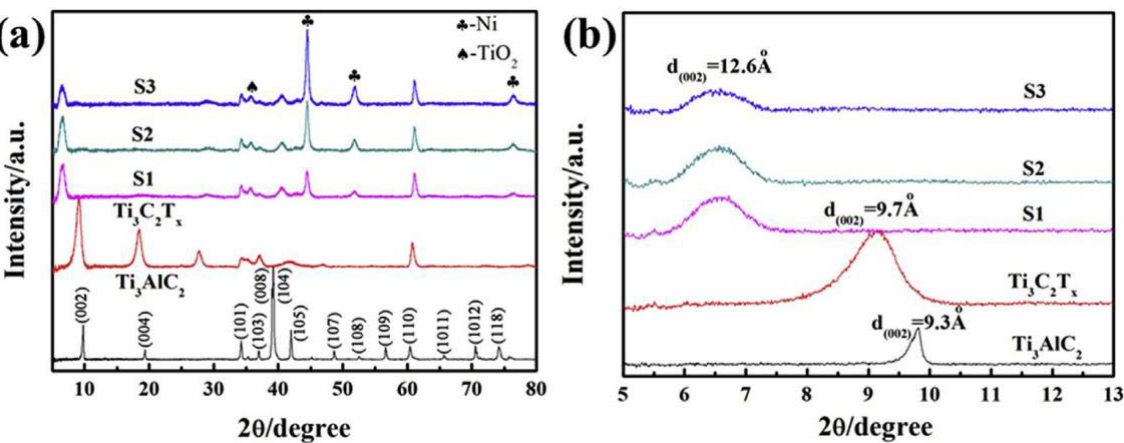
Figure 5. ( a ) XRD patterns of Ti 3 AlC 2 , Ti 3 C 2 T x and Ti 3 C 2 T x /Ni-sphere hybrids. ( b ) Zoomed-in views of ( a ) in the 2θ range of 5° –13°. Reprinted with permission from [65]. Copyright 2019 Elsevier.